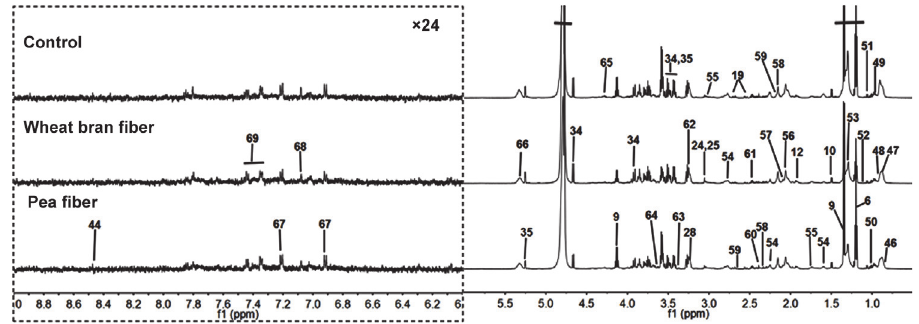
Fig 2. Typical 600 MHz 1 H NMR spectra of plasma metabolites obtained from the (A) control, (B) pea fiber, and (C) wheat bran fiber groups. The region of δ 6.0 – 9.0 was magnified 24 times compared with corresponding region of δ 0.5 – 6.0 for the purpose of clarity. Metabolite keys are given in Table